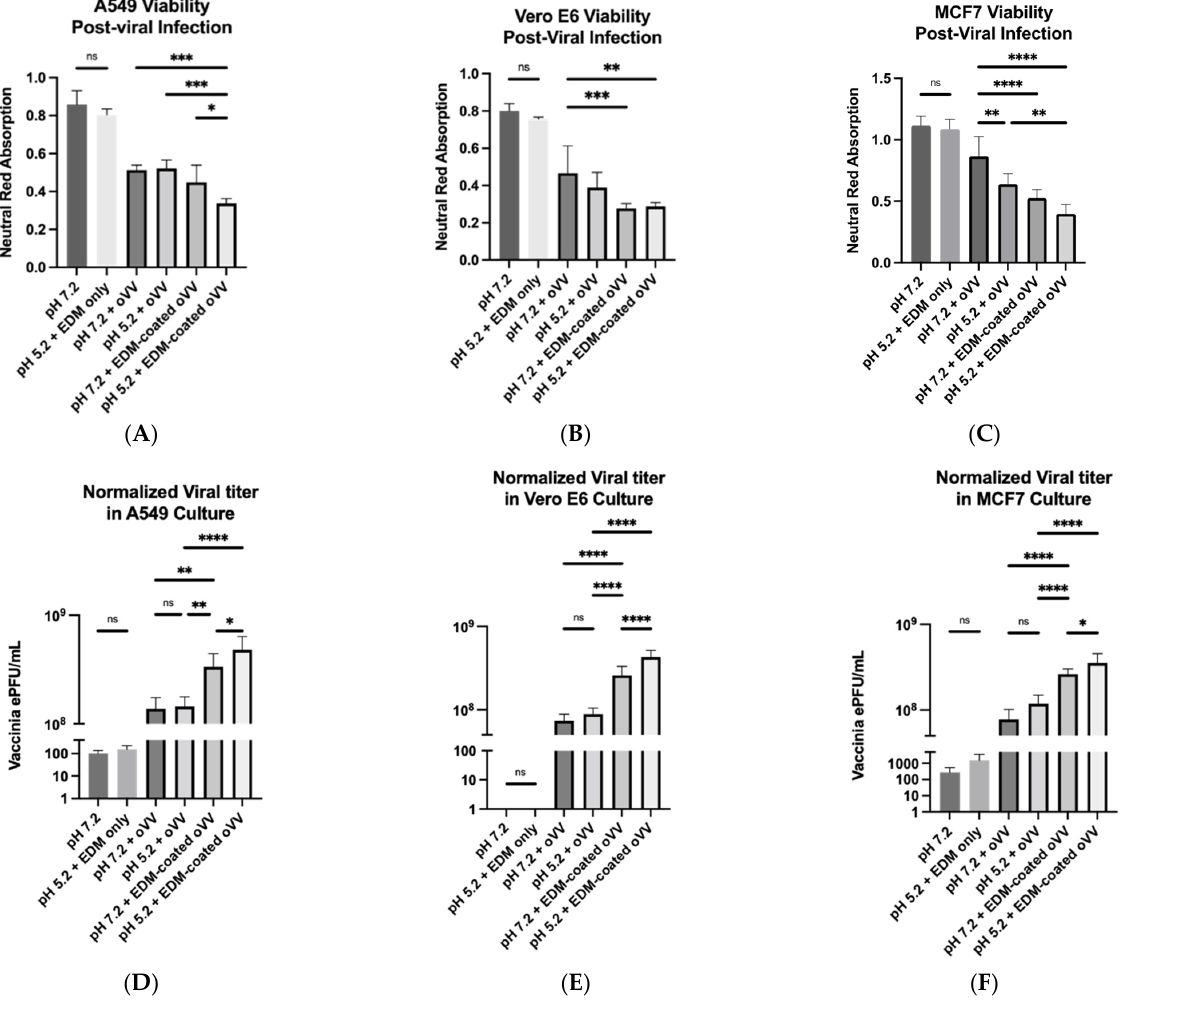
Figure 5. ( A – C ) Neutral red-based viability assay results of various cancer cell lines when oVV/EDM-coated oVV were used to infect at different acidities, along with their accompanying negative controls and vehicle/pH controls; ( D – F ) intracellular viral concentrations at 24 hours post-infection of various cancer cell lines by oVV/EDM-coated oVV at different acidities along with their accompanying vehicle/negative controls. All results are presented as mean ± SD, n = 6. Data were analyzed with ANOVA with Tukey pairwise comparison test. The level of statistical significance was set at probability level ns p ≥ 0.05, * p < 0.05, ** p < 0.01, *** p < 0.001, **** p < 0.0001. To better understand the role of environmental cues in viral-mediated oncolysis, we quantified the viral titer in the cell lysate using qPCR to obtain an intracellular viral con- centration. The exact concentrations were obtained by fitting the CT values onto a stand- ard curve with known viral concentrations. This viral concentration is then normalized to the neutral red assay readout to normalize our results to the number of remaining cells left in the culture. Here, we see the intracellular virus titers increase across the experi- mental samples ranging from (1) neutral pH + bare virus; (2) acidic pH + bare virus; (3) neutral pH + coated virus; and (4) acidic pH + coated virus (Figure 5D, 5E, and 5F). We also measured virus titers in our controls as comparison to show the baseline noise in the absence of any viruses. (3) We consistently registered only a slight increase in virus